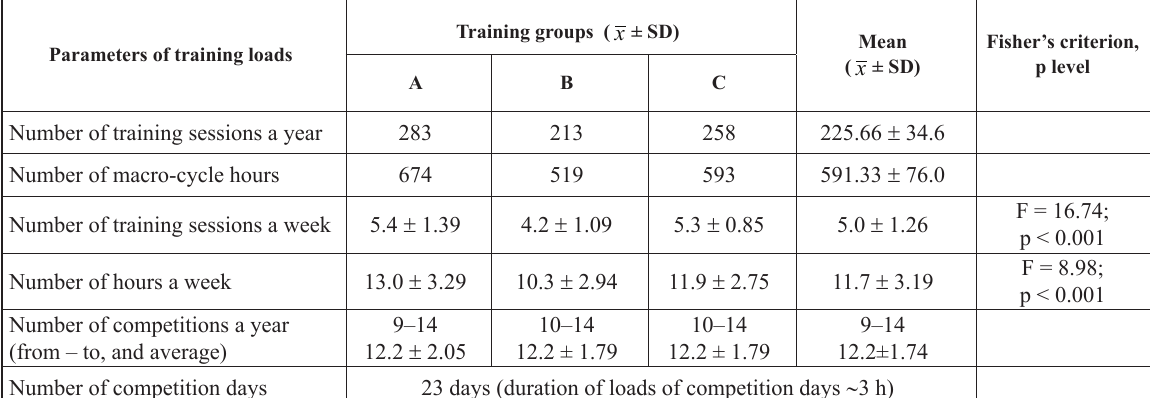
Table 2. Training loads of different training programs of 13–14-year-old athletes in rhythmic gymnastics